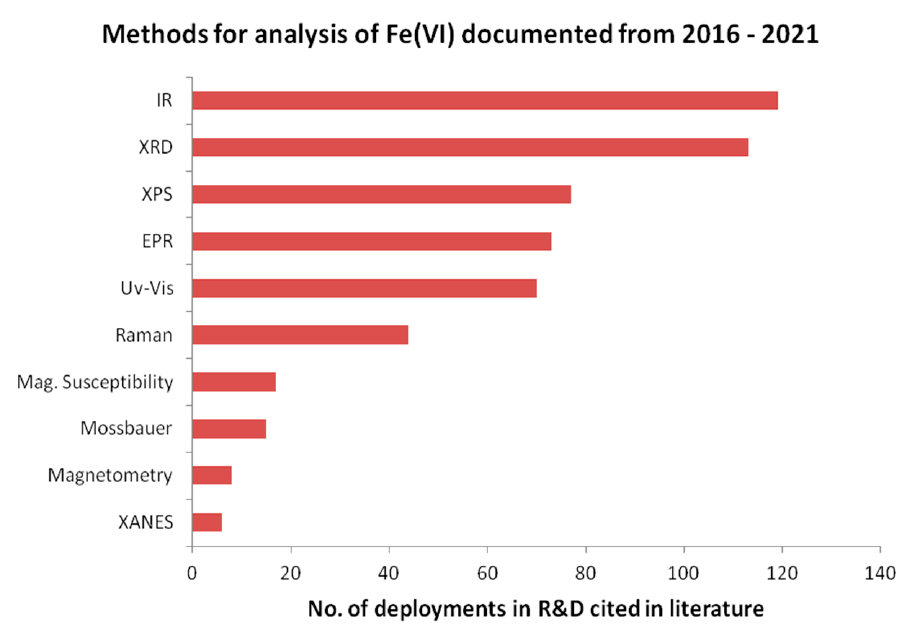
Figure 1. Methods of analysis of Fe(VI) moieties documented in literature sampled between 2016– 2021. (Spectral methods: IR = infrared/reflectance/Fourier Transform, XRD = X-ray diffraction, XPS = X-ray photoelectron spectroscopy, EPR = electron paramagnetic resonance, UV-Vis = ultraviolet & visible, followed by Raman spectroscopy, Magnetic Susceptibility, Mössbauer spectroscopy and XANES = X-ray absorption near-edge spectra).